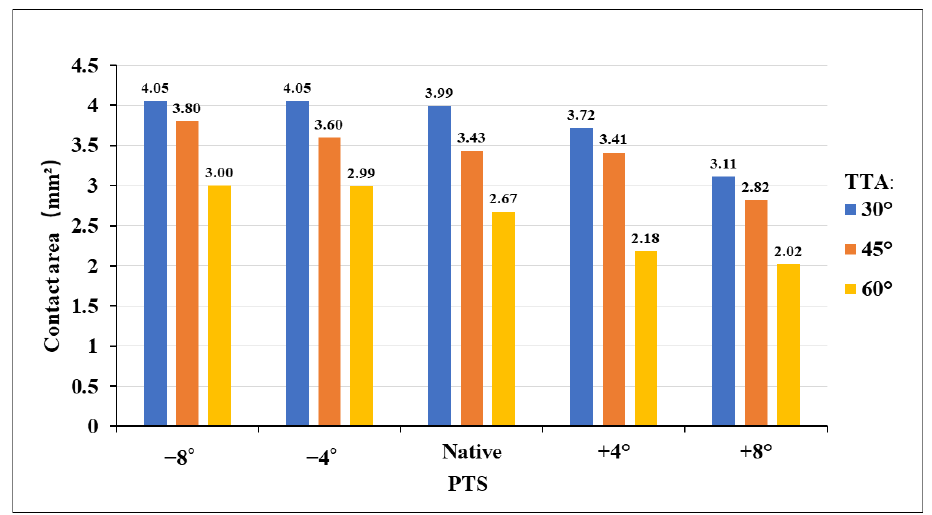
Figure 5. Bar chart contact stress area (greater than 10 MPa) diagram for different TTAs and PTSs at the entrance of the tibial tunnel. TTA: tibial tunnel angle, PTS: posterior tibial